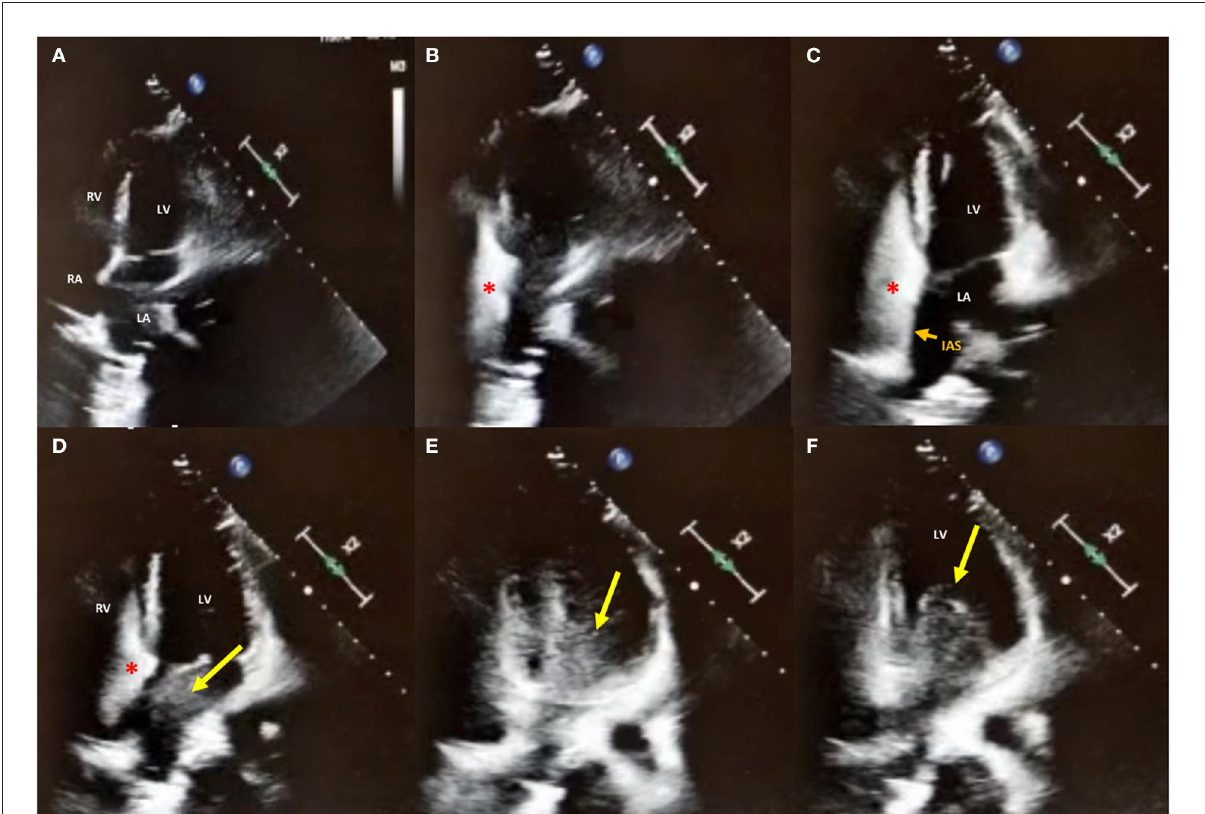
FIGURE2 2D contrast-Transthoracic Echocardiography in apical 4-chambers view in basal conditions. (A–C) Agitated saline injection (red asterisk) from the right antecubital vein showed no right-to-left shunt (RLS) across the interatrial septum (IAS; small orange arrow); (D–F) While still no bubbles were crossing the interatrial septum, a delayed (17s) RLS coming from left pulmonary veins to LA and LV through the mitral valve is shown, confirming the diagnosis of extra-cardiac RLS. LA, left atrium; RA, right atrium; LV, left ventricle; RV, right